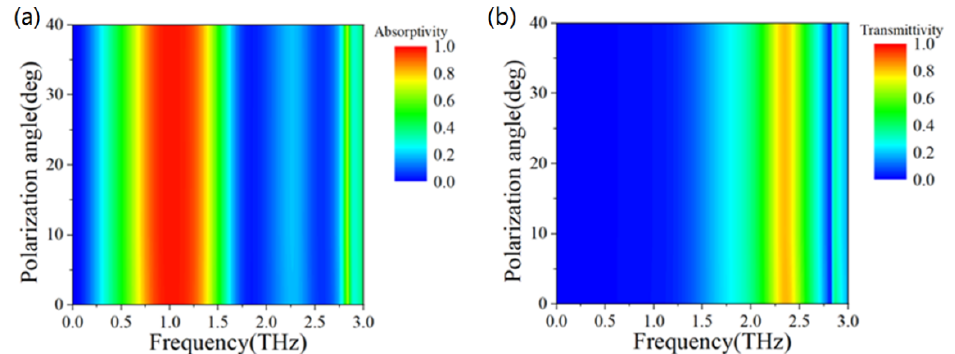
Figure 6. ( a ) The simulation results of absorption rate changing with different polarization angles; ( b ) Transmittance changing with different polarization angles.